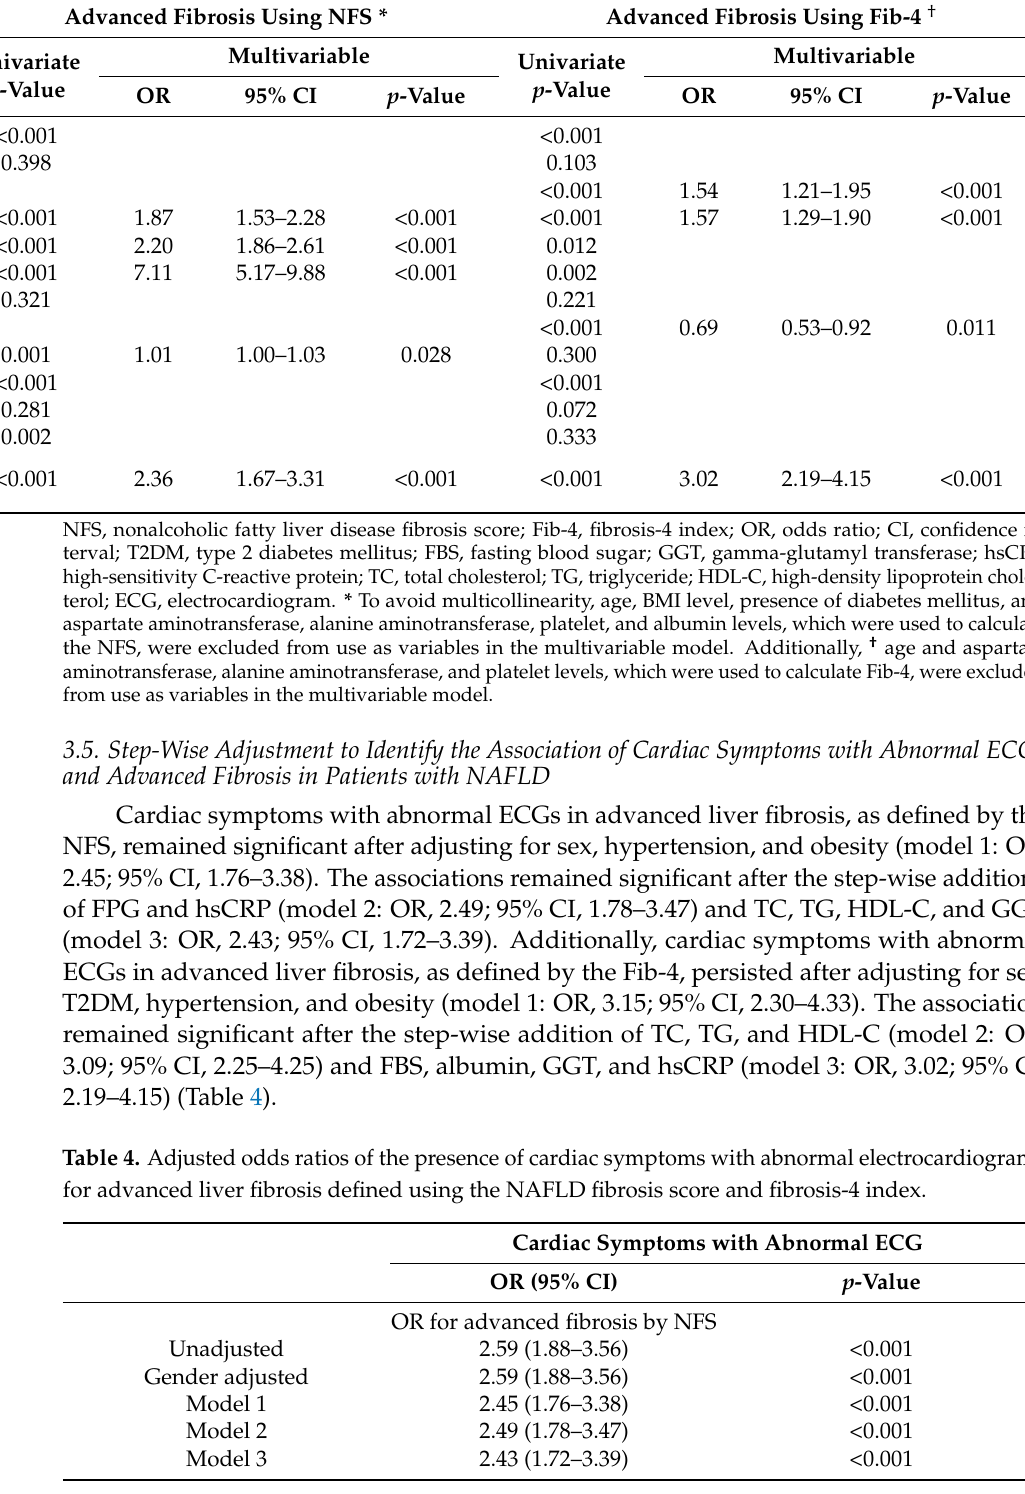
Table 3. Multivariable analysis of variables associated with advanced fibrosis in patients with nonalcoholic fatty liver disease.